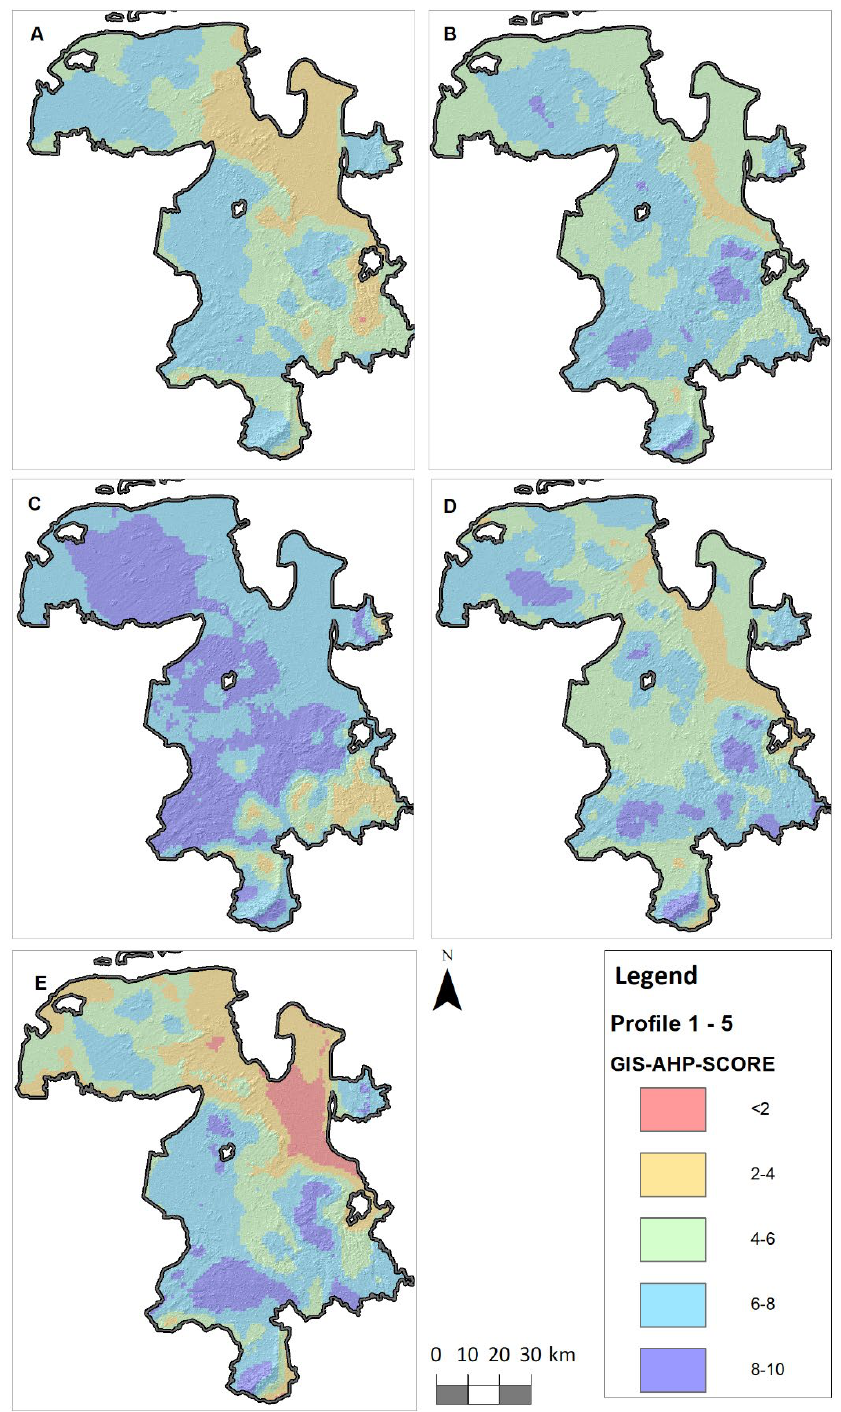
Figure 5. Results of the GIS-AHP rating (GIS-AHP-Score) per rating profile (0 = insufficient site conditions, 10 = ideal site conditions): ( A ) profile 1 with focus on T and GRB, ( B ) profile 2 with focus on T and DGT, ( C ) profile 3 with focus on T, ( D ) profile 4 with focus on GWP and GWR, and ( E ) profile 5 with focus on GRB and